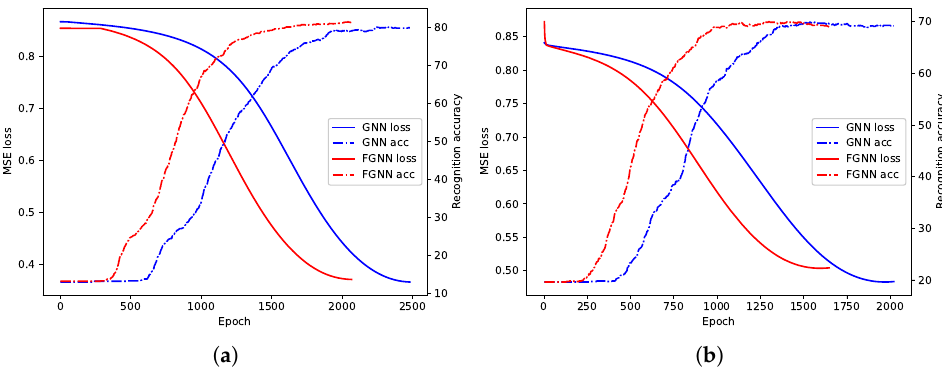
Figure 7. Testing MSE loss and recognition accuracy (%) curves of GNN and FGNN on ( a ) Cora and ( b ) Citeseer. The horizontal axis denotes training epochs in the semi-supervised tasks. The left vertical axis denotes the MSE loss. The right vertical axis denotes the recognition accuracy.